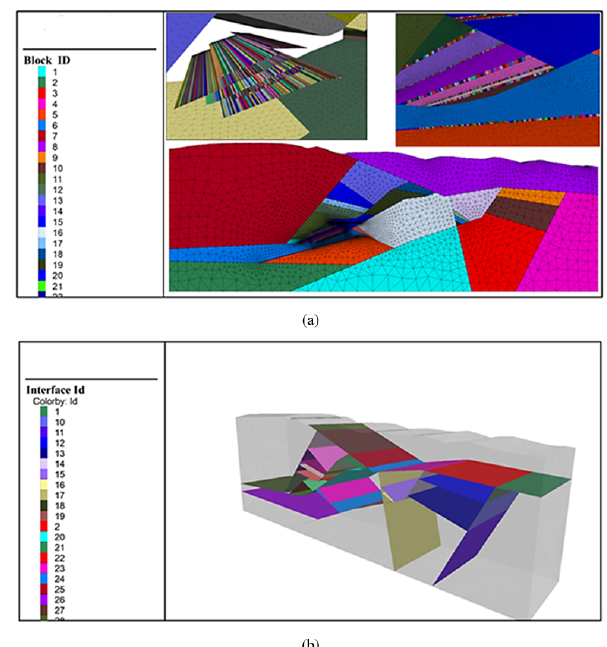
Figure 2. (a) Generated 3D geometry of the model considering the mesh refinement around the excavation area; “block ID” refers to the zones generated in the model. (b) Faults in the model repre- sented as zero-thickness